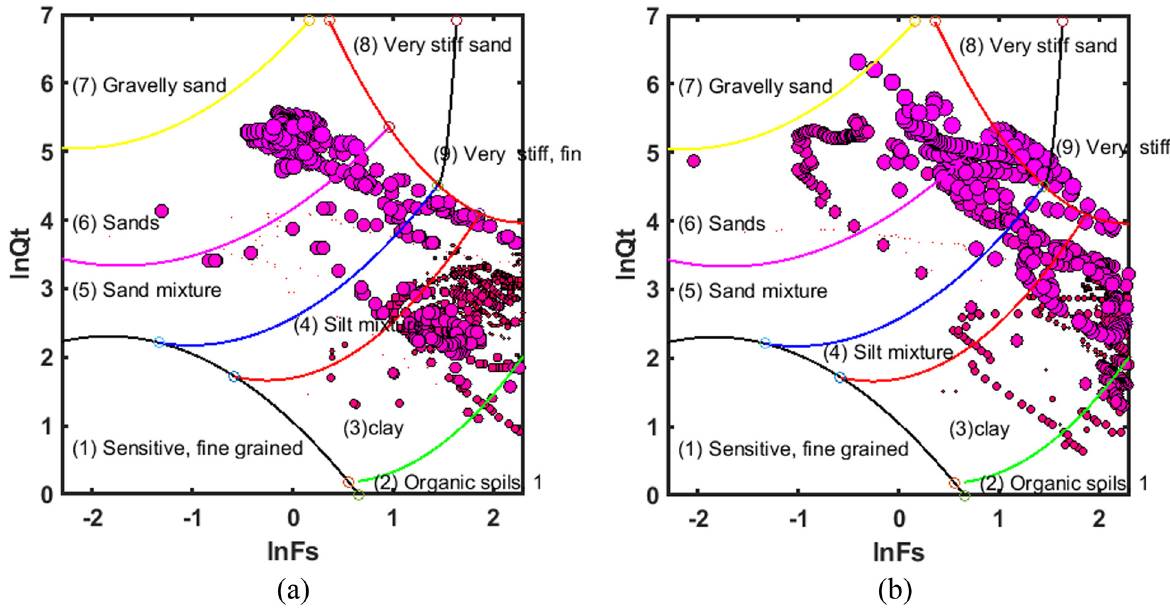
Figure 4: Points of ln Q t and ln F s in the physical space proposed by Robertson, 2010: ( a ) CPT3 and ( b ) CPT4.